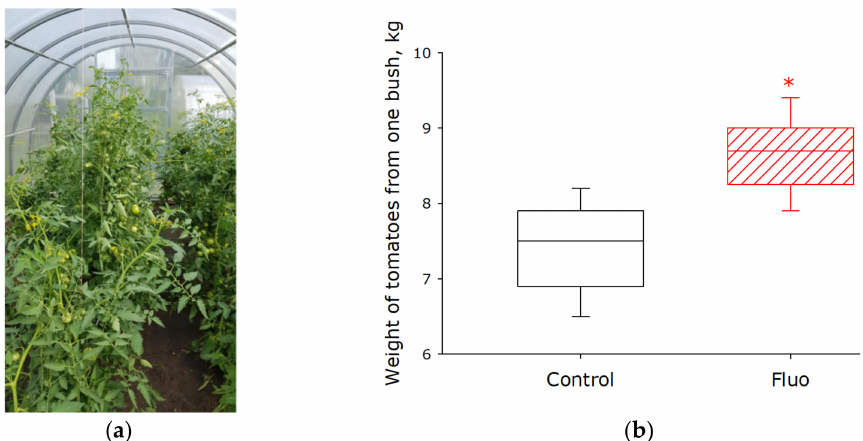
Figure 5. Influence of the photoconversion fluoropolymer film on the development of tomato plants. ( a ) Photo of tomatoes grown inside a greenhouse made from photoconversion polymer film. ( b ) Weight of tomato fruits harvested from one tomato bush grown under a control plastic film and photoconversion polymer film. Data are presented as median with 95% confidence interval (box). The range is shown in the form of a whiskers. Statistically significant di ff erences between control group and other groups (Mann-Whitney U test, p < 0.05) are marked by